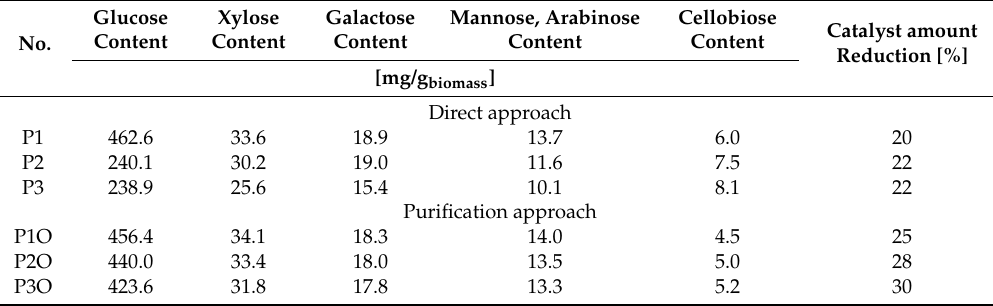
Table 7. Content of monosugars in hydrolysates after MEA re-use.